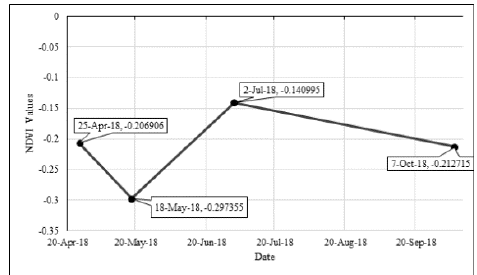
Figure 4. Mean and standard deviation of NDVI (Normalized Difference Vegetation Index) values.